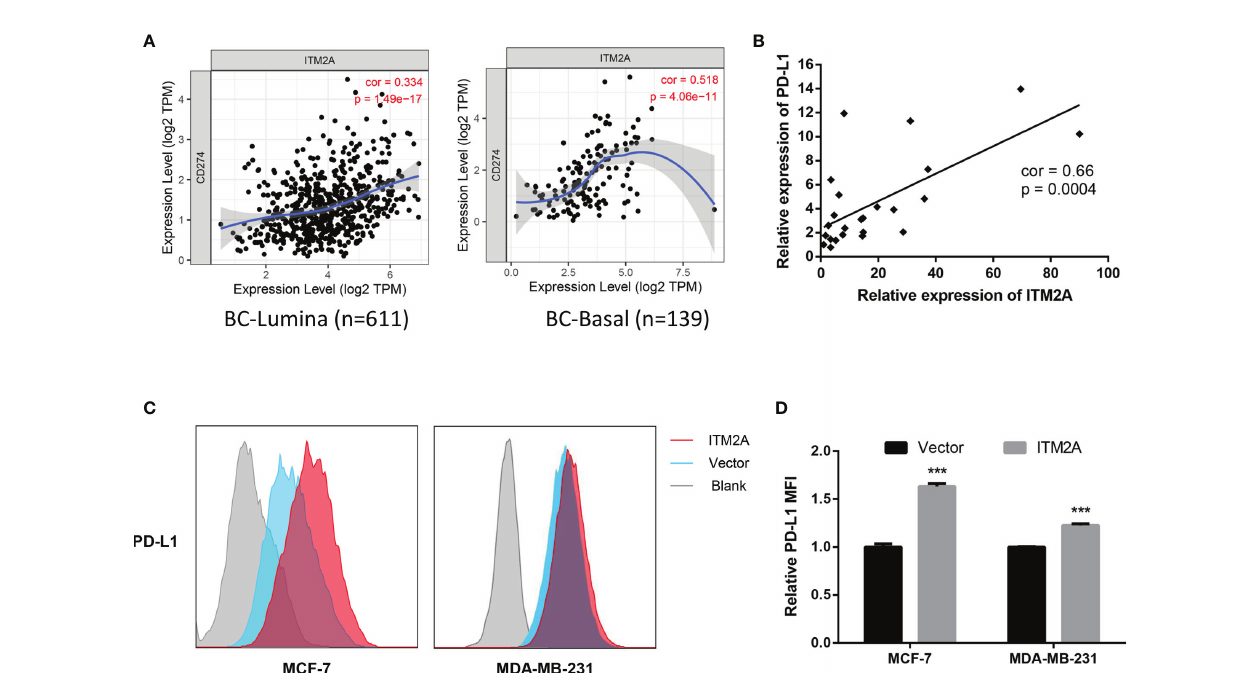
FIGURE 5 | ITM2A increased PD-L1 expression in breast cancer cells. (A) Correlations between PD-L1 and ITM2A expression in lumina breast cancer (left) and basal breast cancer (right) based on TIMER database. (B) Correlation between PD-L1 and ITM2A expression in collected 24 breast cancer specimens. (C, D) MCF-7 and MDA- MB-231 cells were transfected with indicated plasmid. PD-L1 expression in these cells 48 hours after transfection was tested by fl ow cytometric analysis. ***p < 0.001.